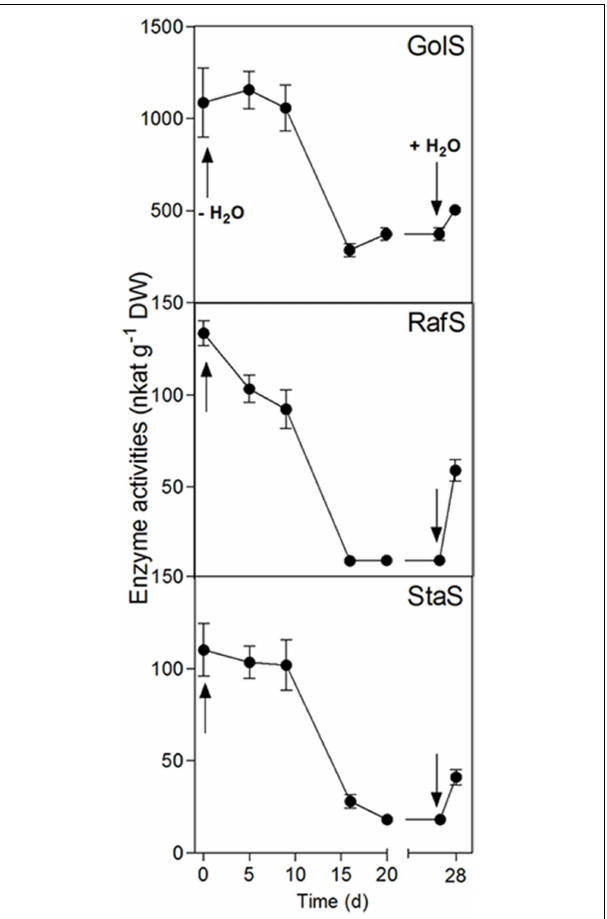
FIGURE 4 | Enzyme activity changes in the leaves of C. plantagineum plants subjected to a 20 d water deficit stress. Plants were then held in a dried state for 7 d and water deficit was alleviated by re-watering the plants. Enzyme activities were analyzed by HPLC-PAD using a BC100 column. Error bars indicate the standard error between the mean of six replicates. GolS, galactinol synthase; RafS, raffinose synthase; StaS, stachyose